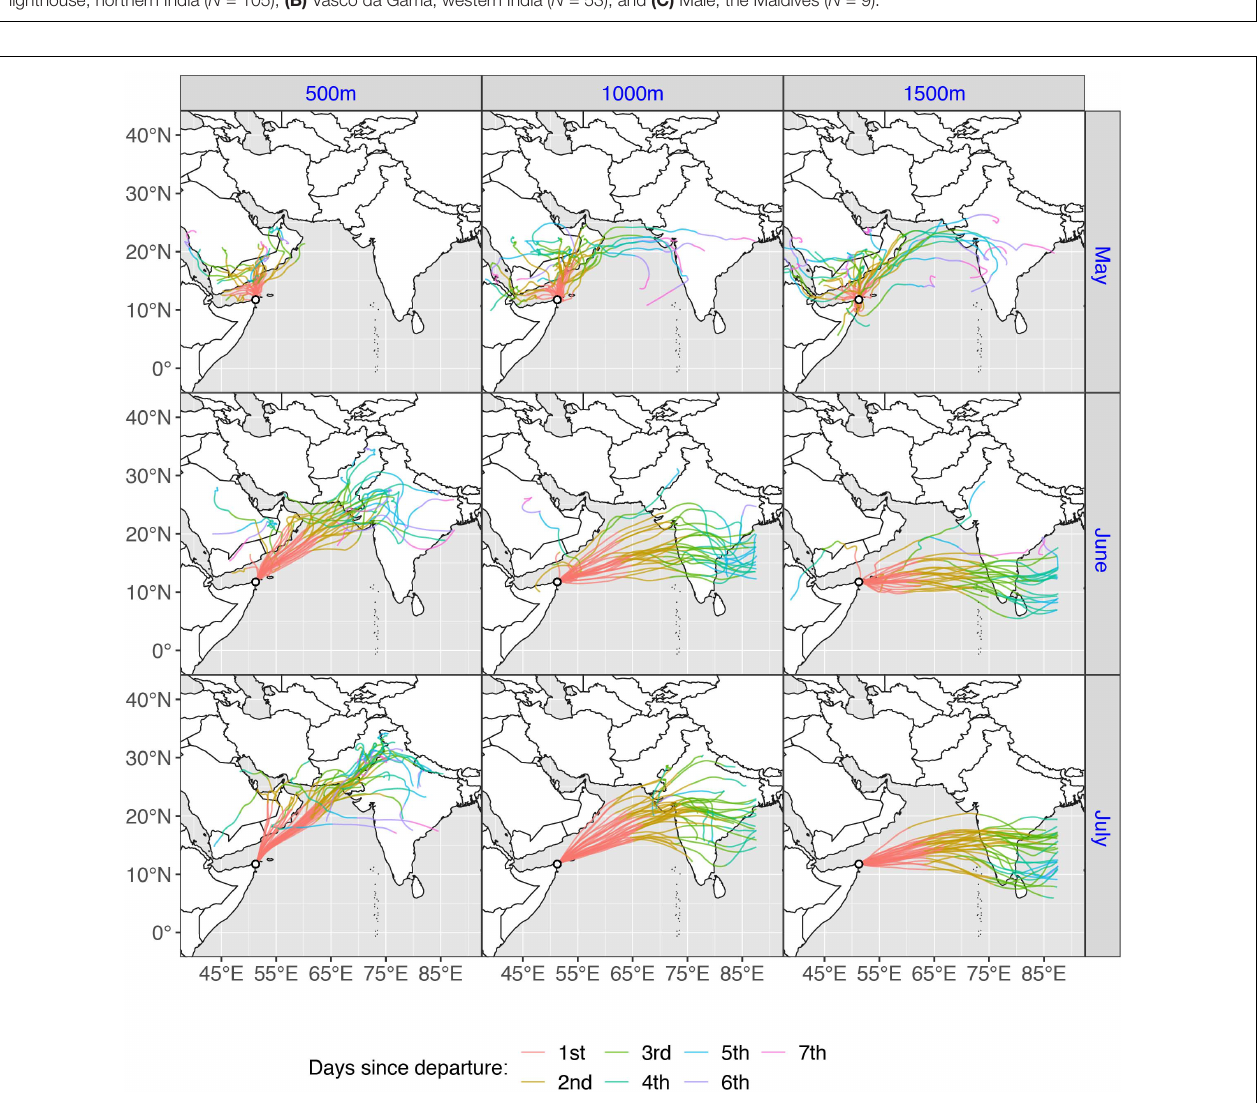
FIGURE 8 | Spring wind trajectories ( N = 366) for one departure site, Guardafui lighthouse, Somalia, during May–July, for three starting heights (500, 1,000, and 1,500 m). Colors denote the number of days (flystage) since departure (1–6). As the model adheres to a limited geographical scope, trajectories that exceeded the boundary (approximately 87 ◦ E longitude) will stop, thus trajectories traveling eastward across the Bengal Sea are cut short.